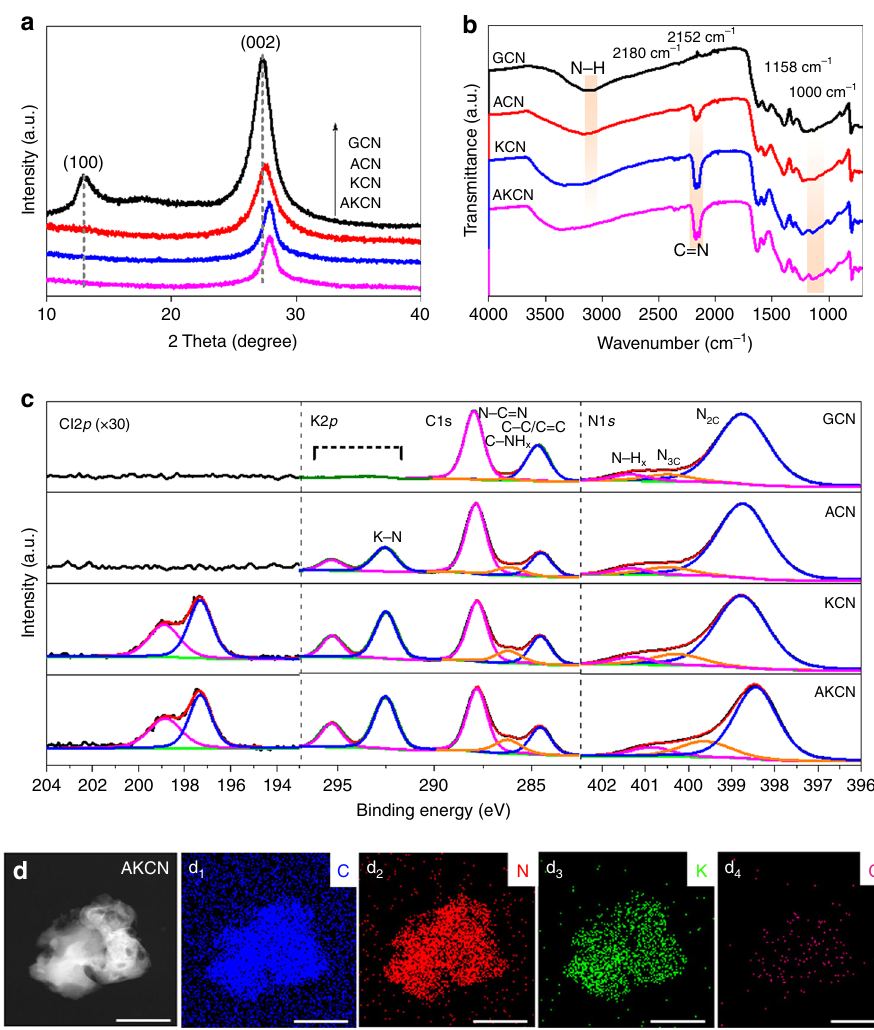
Fig. 2 Characterization of the bifunctional nanozyme. a XRD patterns, b FTIR spectra, and c Cl 2 p , K 2 p , C 1 s and N 1 s XPS spectra of GCN, ACN, KCN, and AKCN. The red line and green line represent the peak simulation and baseline. The deconvoluted peaks was identi fi ed from the pink, blue, and orange line. d TEM image of AKCN with corresponding elemental mapping ( d 1 – d 4 ). The scale bar is 1 µ m in fi gures. The colours of blue, red, green, and pink represent the elemental components of d 1 C, d 2 N, d 3 K, and d 4 Cl, respectively. Source data are provided as a Source Data fi